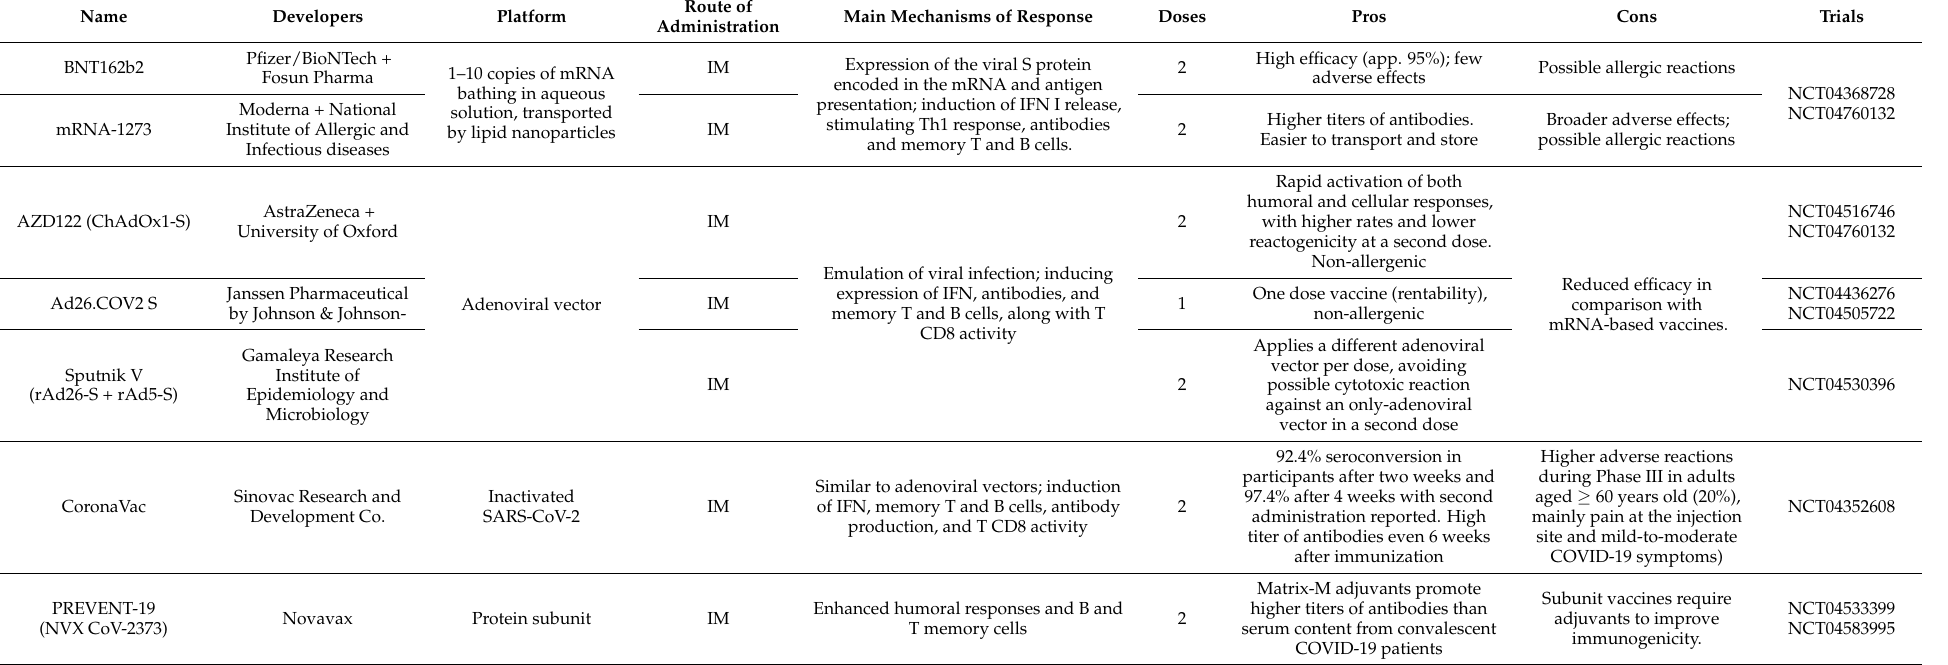
Table 1. Summary of the main COVID-19 vaccines currently distributed worldwide. IM,